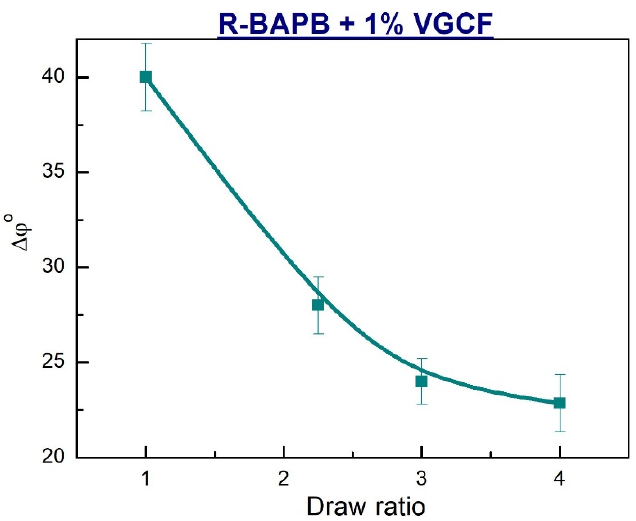
Figure 8. Dependences of the angle of misorientation (along the fiber axis) of the polymer crystallites on the draw ratio of the composite fibers based on R-BAPB loaded with 1 wt.% VGCF.